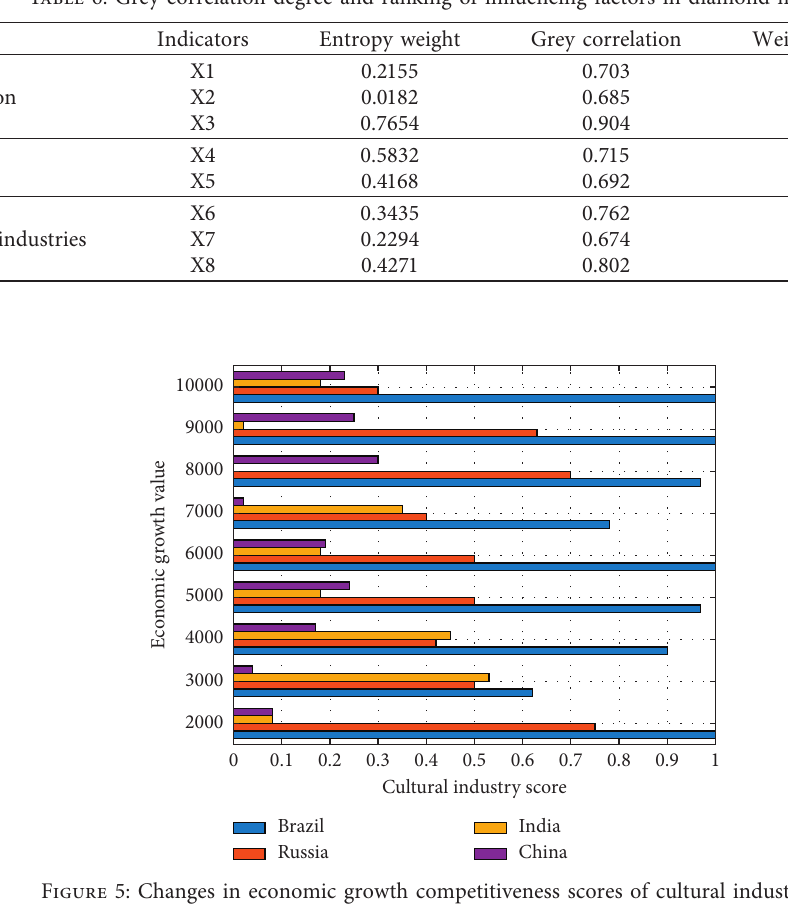
Table 6: Grey correlation degree and ranking of influencing factors in diamond model.